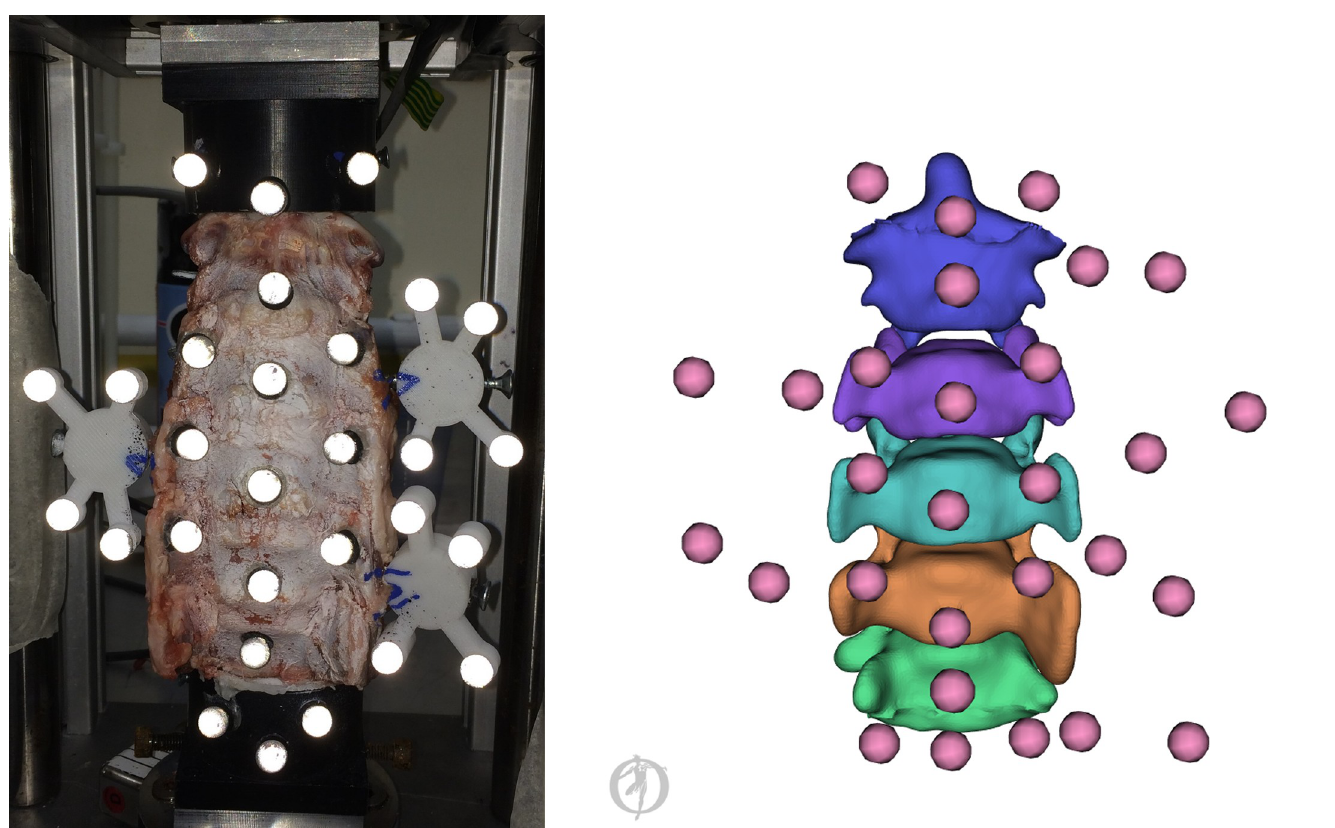
Fig 1. Experimental set up of the spinal specimen positioned in the impact rig (left) and digital representation as a specimen specific model with virtual registered markers (right) . Markers secured to the anterior aspect of the specimen and the cranial and caudal pots were used for the registration process during model creation. The markers of the cranial pot and the clusters secured to the C3, C4 and C5 vertebrae were used as tracking markers in the optimisation.